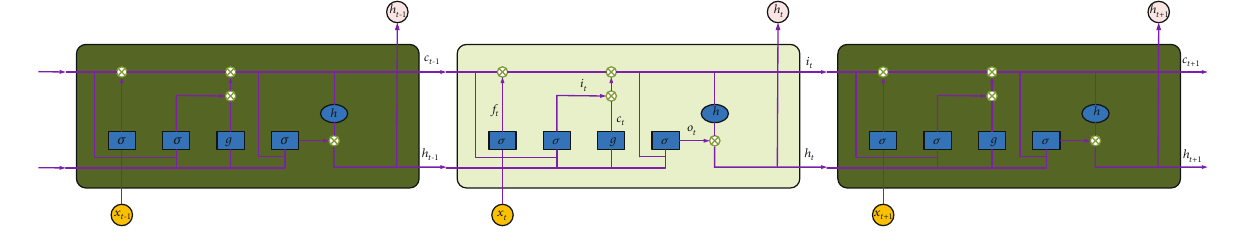
Figure 3: LSTM model with multiple memory